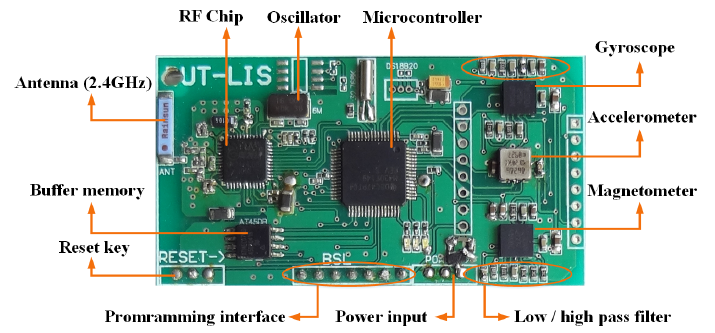
Figure 3. Circuitboard of the proposed sensor node.